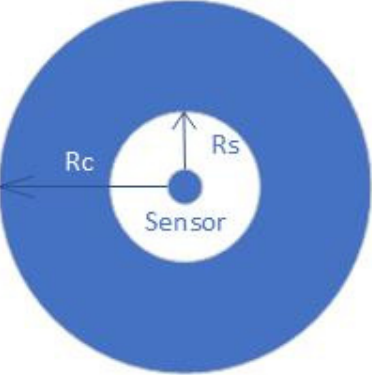
Figure 8. Sensing range Rs and communication range Rc.